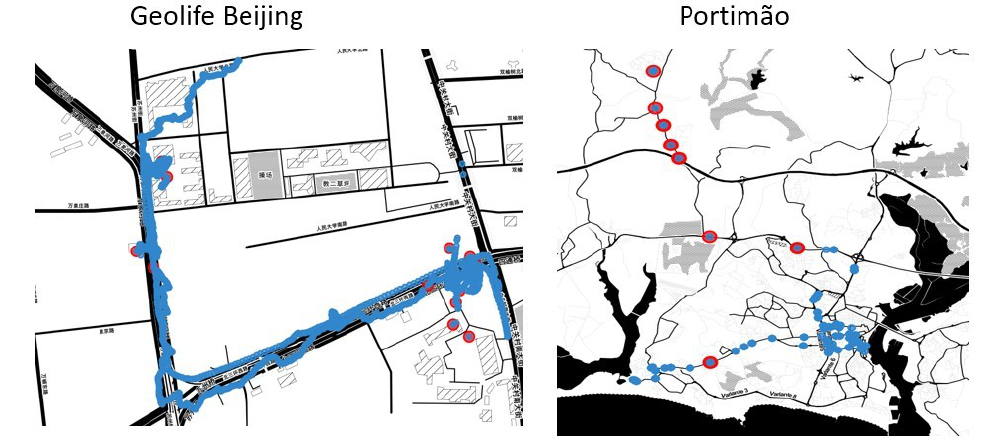
Figure 4. Illustration of detected outliers in the GEO and PTM datasets with DBSCAN. Outliers are highlighted in red.